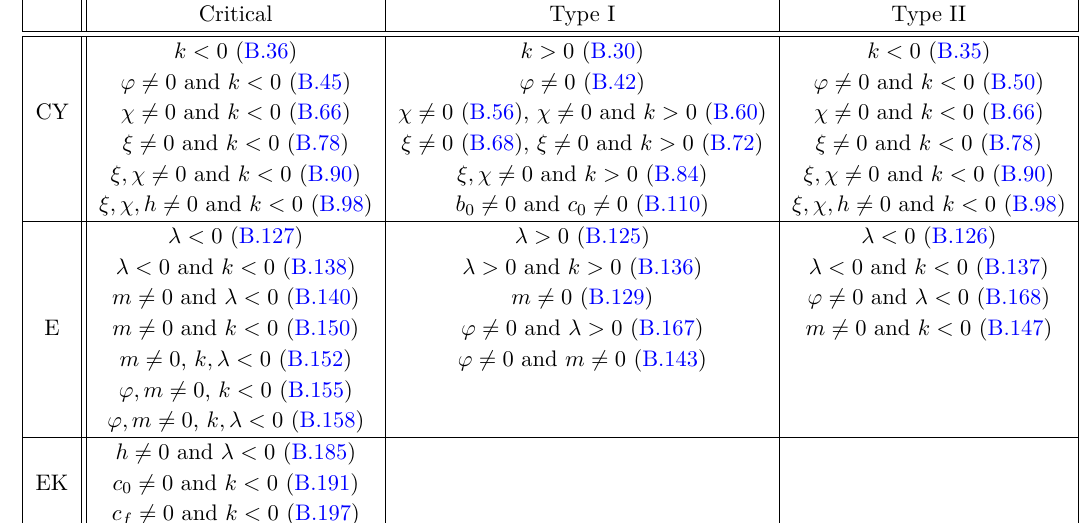
Table 3 . All analytic solutions presented in this paper, besides the zero-flux, flat 4d space solution of section 5.1. We list the corresponding compactification manifold, the type of non-vanishing flux, together with a reference to the explicit details of the solution. Critical solutions correspond to fixed points in the dynamical-system description. All CY critical points correspond to regular Milne universes except the one with ϕ 6 = 0 , which is a Milne universe with angular defect. The λ < 0 critical point corresponds to a scaling cosmology with a = 3 . The m 6 = 0 , λ < 0 critical point 4 corresponds to a scaling cosmology with a = 19 . The k , λ , m , ϕ 6 = 0 solution corresponds to AdS 4 25 in hyperbolic slicing. The h 6 = 0 , λ < 0 critical point corresponds to a scaling cosmology with . All the other critical points correspond to Milne universes with angular defects. Type I a = 9 11 solutions always correspond to trajectories interpolating between two points of the equator. Type II solutions interpolate between a fixed point on the equator and an interior fixed point. For all type II CY solutions, the internal space warp factor e A and the dilaton φ tend to a constant at future infinity, except for the ϕ 6 = 0 solution for which e A , e φ → ∞ . For all type II Einstein solutions, e A → ∞ , φ → const. at asymptotic infinity, except for the ( m, k ) solution for which e φ → 0 .